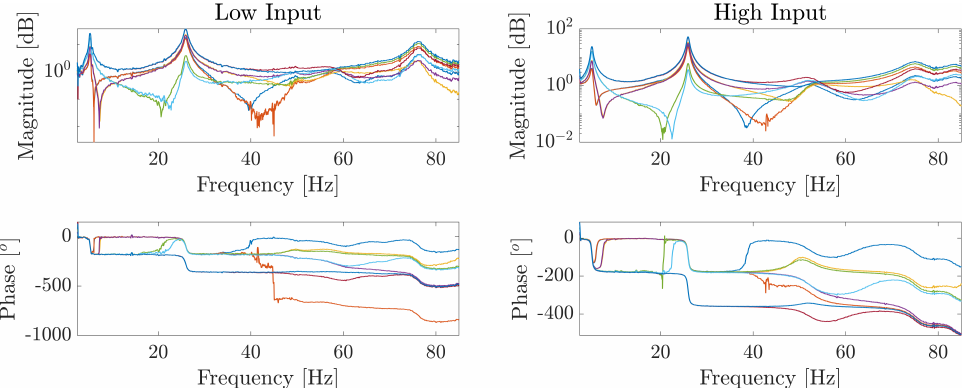
Figure 16. Spar and tube: FRFs of the low- and high-input scenarios. All channels are superimposed for